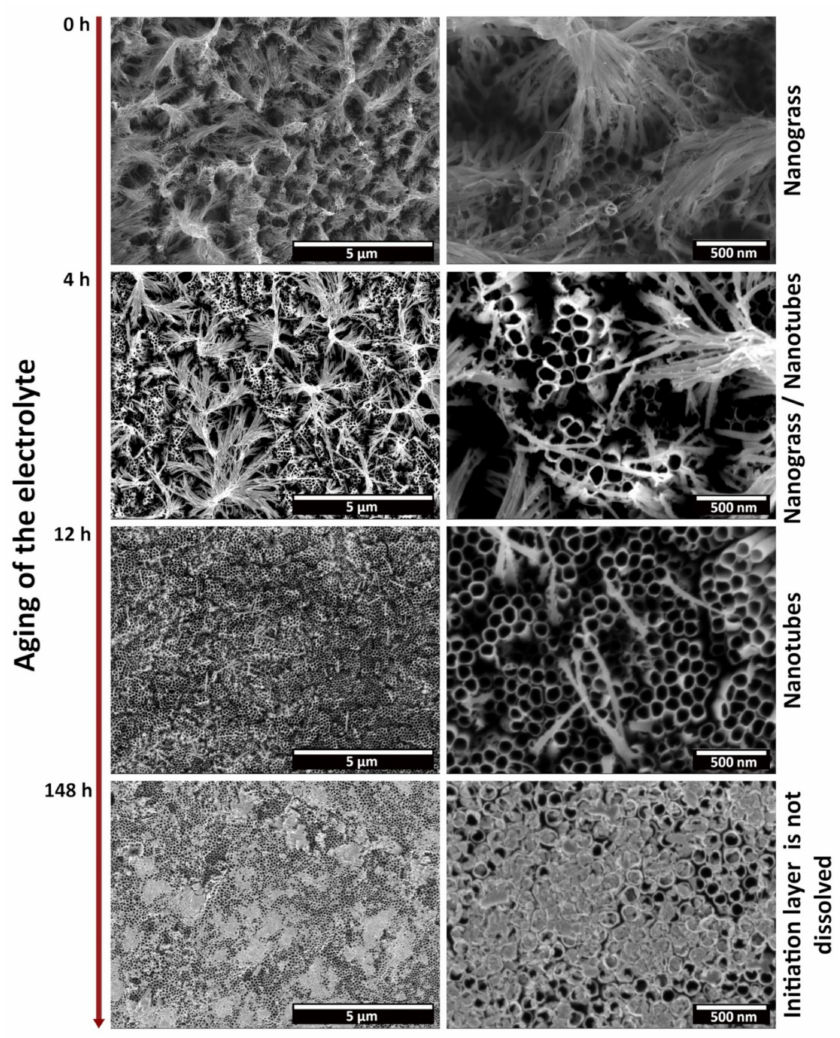
Figure 3. Morphology of the anodic oxide layer grown over CP-Ti, after anodization at 40 V for 4 h, with regard with the aging of the electrolyte. Aging is measured in terms of the accumulated hours of usage of the electrolyte, prior to the anodization of the